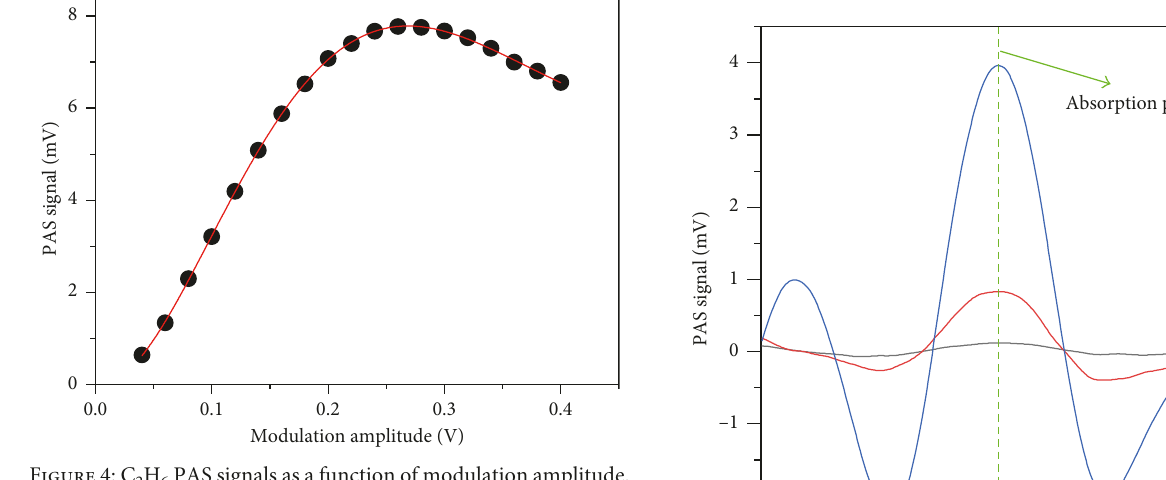
Figure 4: C 2 H 6 PAS signals as a function of modulation amplitude.